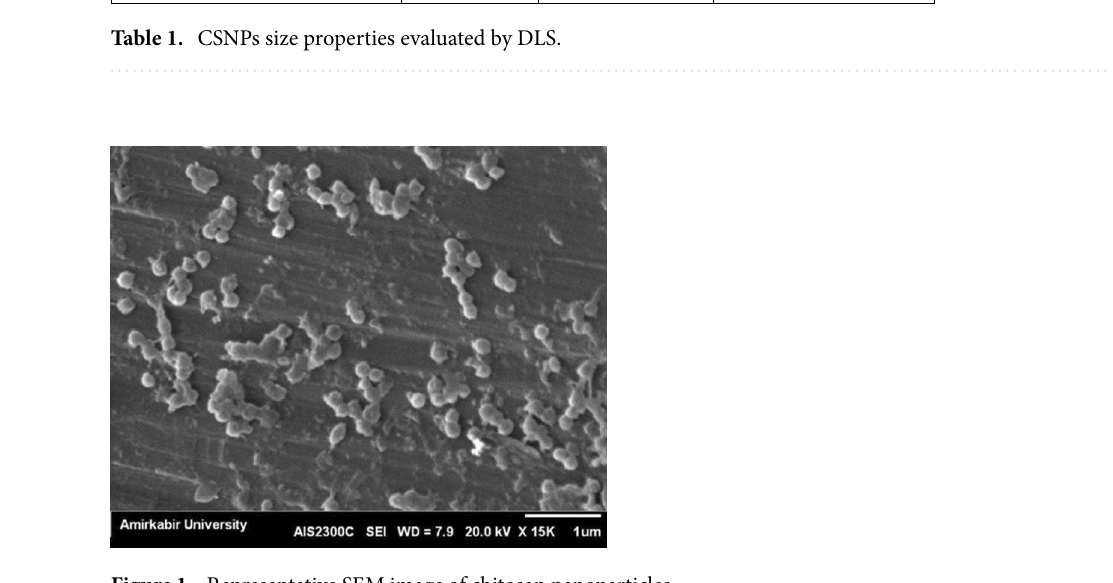
Figure 1. Representative SEM image of chitosan